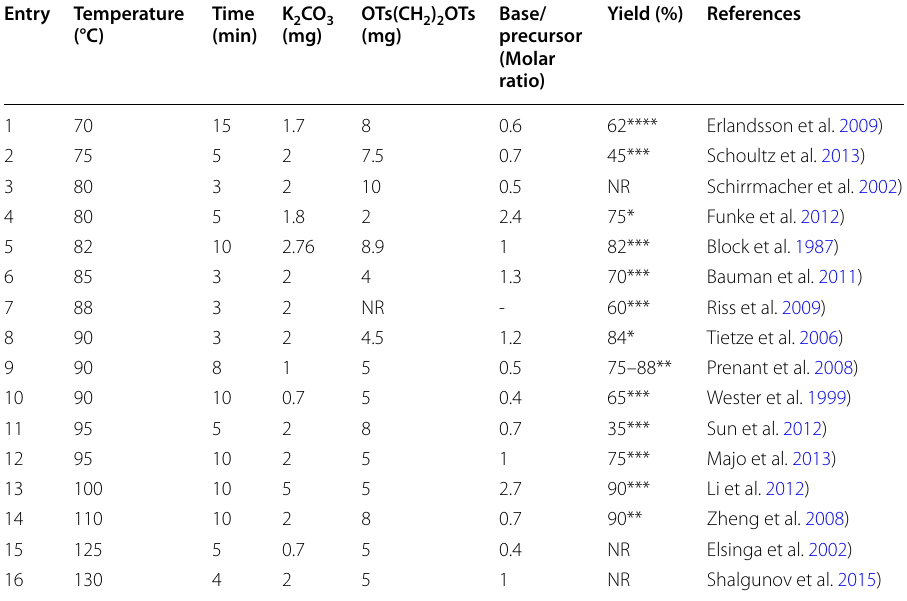
CO and OTs(CH ) OTs, and base/precursor molar 2 3 2 2